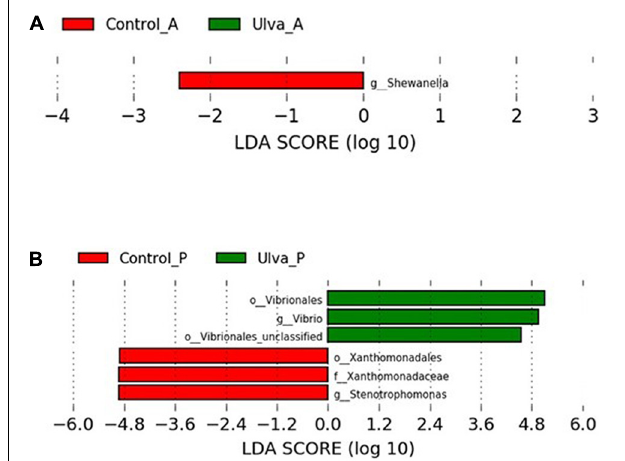
FIGURE 6 | LDA scores for OTUs differentially abundant in the microbiota GI tract of S. senegalensis specimens fed control (Control) and Ulva ohnoi supplemented (Ulva) diets for 90 days (Kruskal–Wallis and Wilcoxon test, p < 0.05 and LDA effect size > | 2.00|). (A) anterior section; (B) posterior